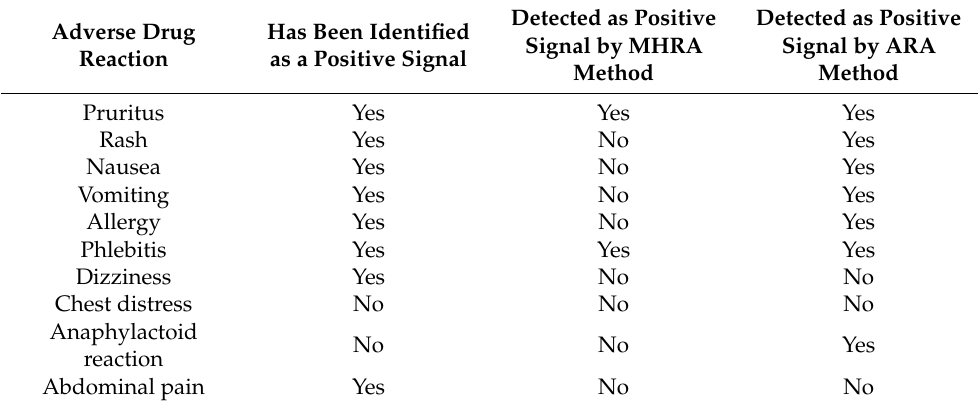
Table 5. ADRs of levofloxacin and related detection signals.